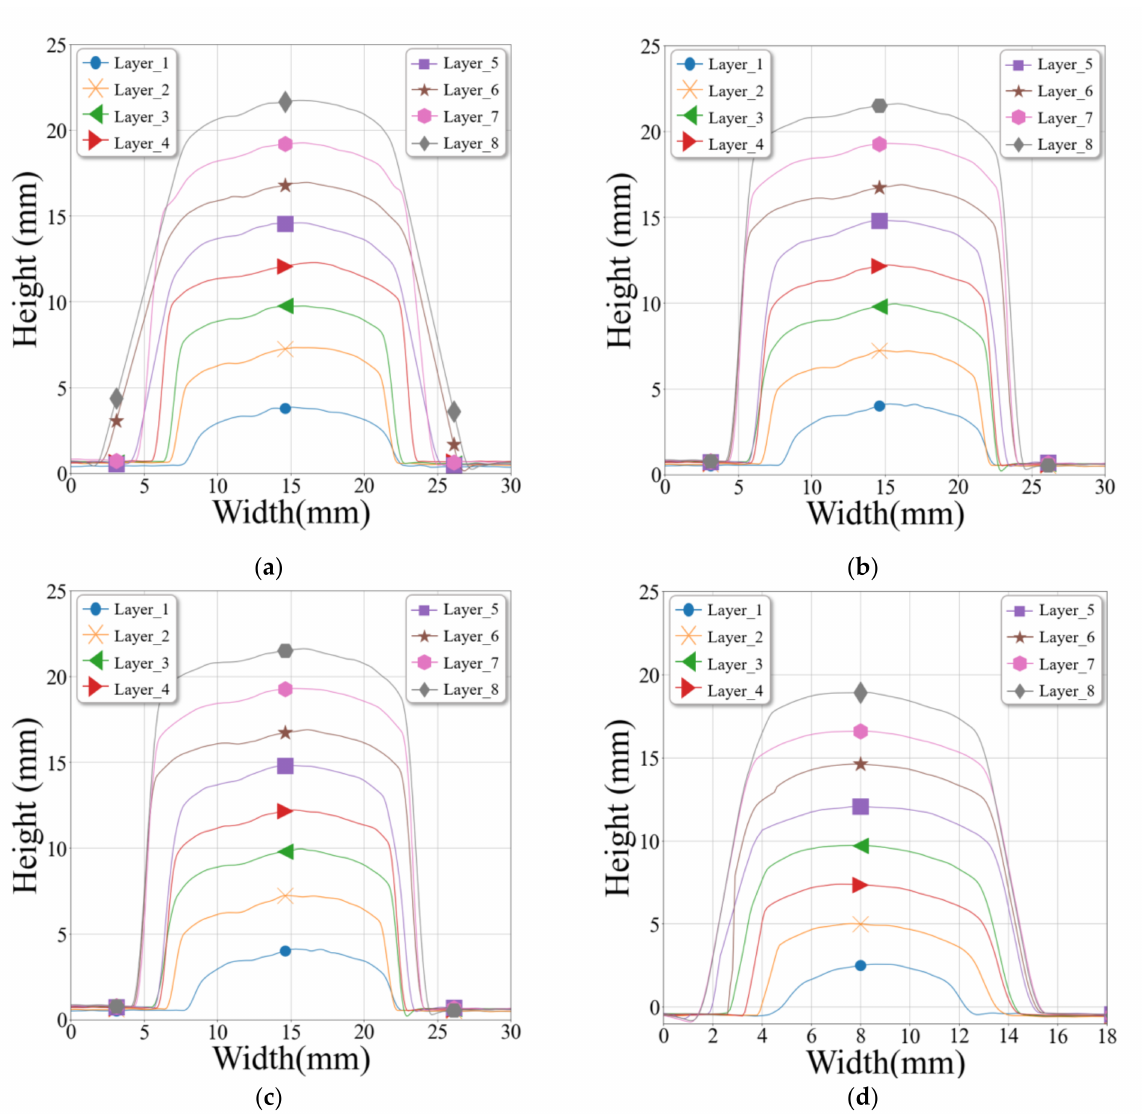
Figure 11. Graph of bead height and width at each layer: ( a ) section view A-A, ( b ) section view D-D, ( c ) section view B-B and ( d ) section view